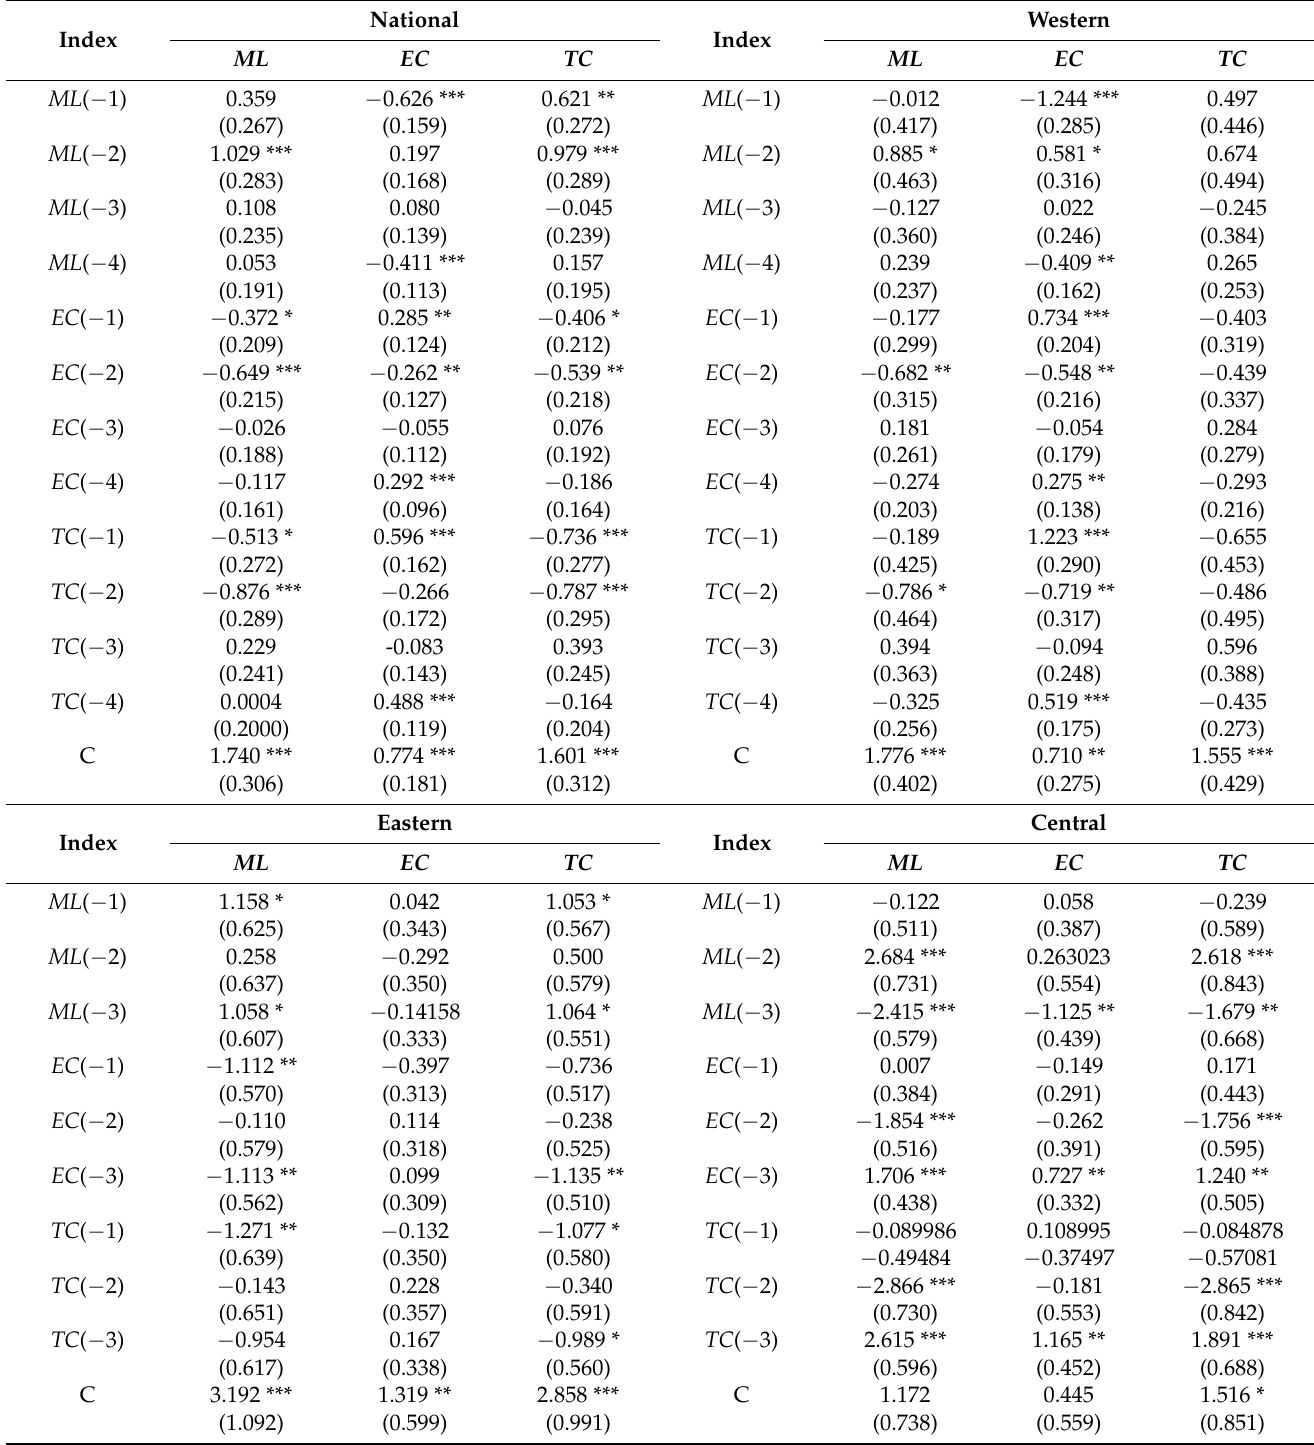
Table 9. Results of